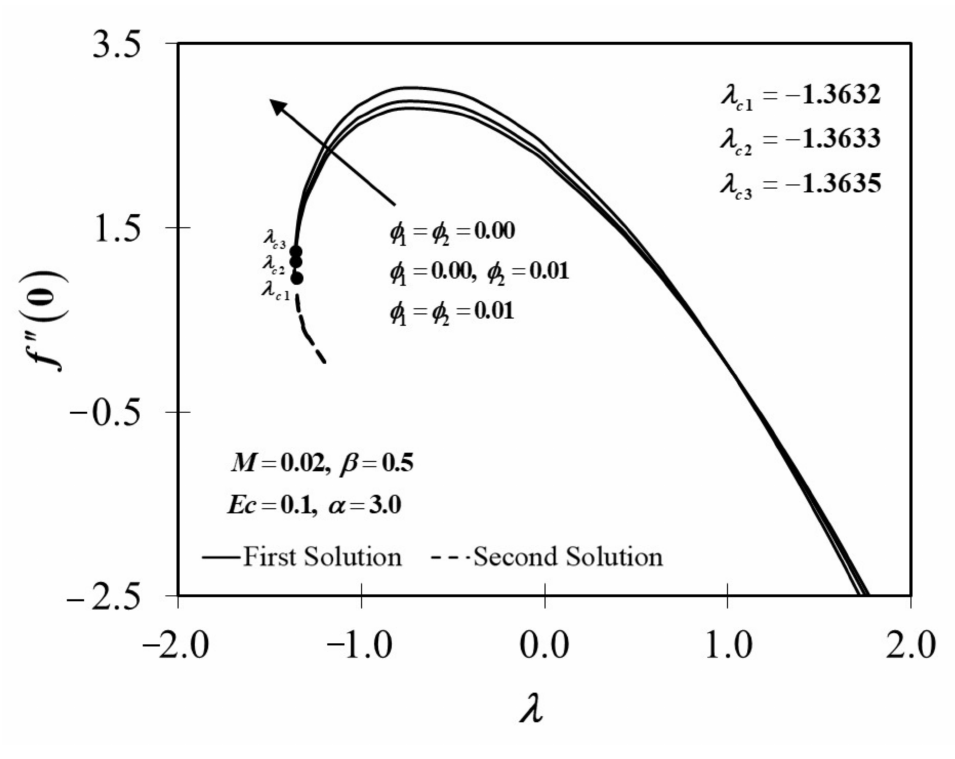
Figure 2. f (cid:48)(cid:48) ( 0 ) versus λ with specific φ .